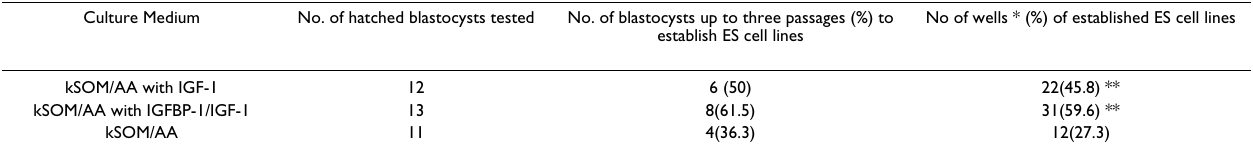
No of wells * (%) of established ES cell lines establish ES cell lines